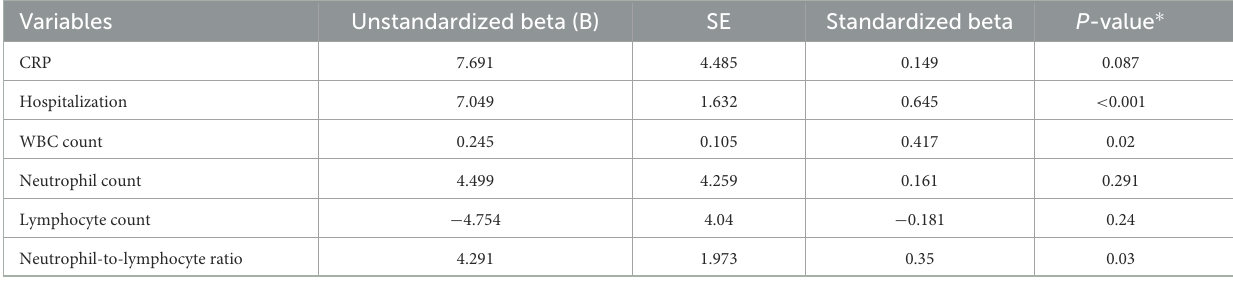
TABLE 5 Association of inflammatory and immune system biomarkers with energy-adjusted dietary inflammatory index (E-DII) in patients with COVID-19 based on multiple linear regression.